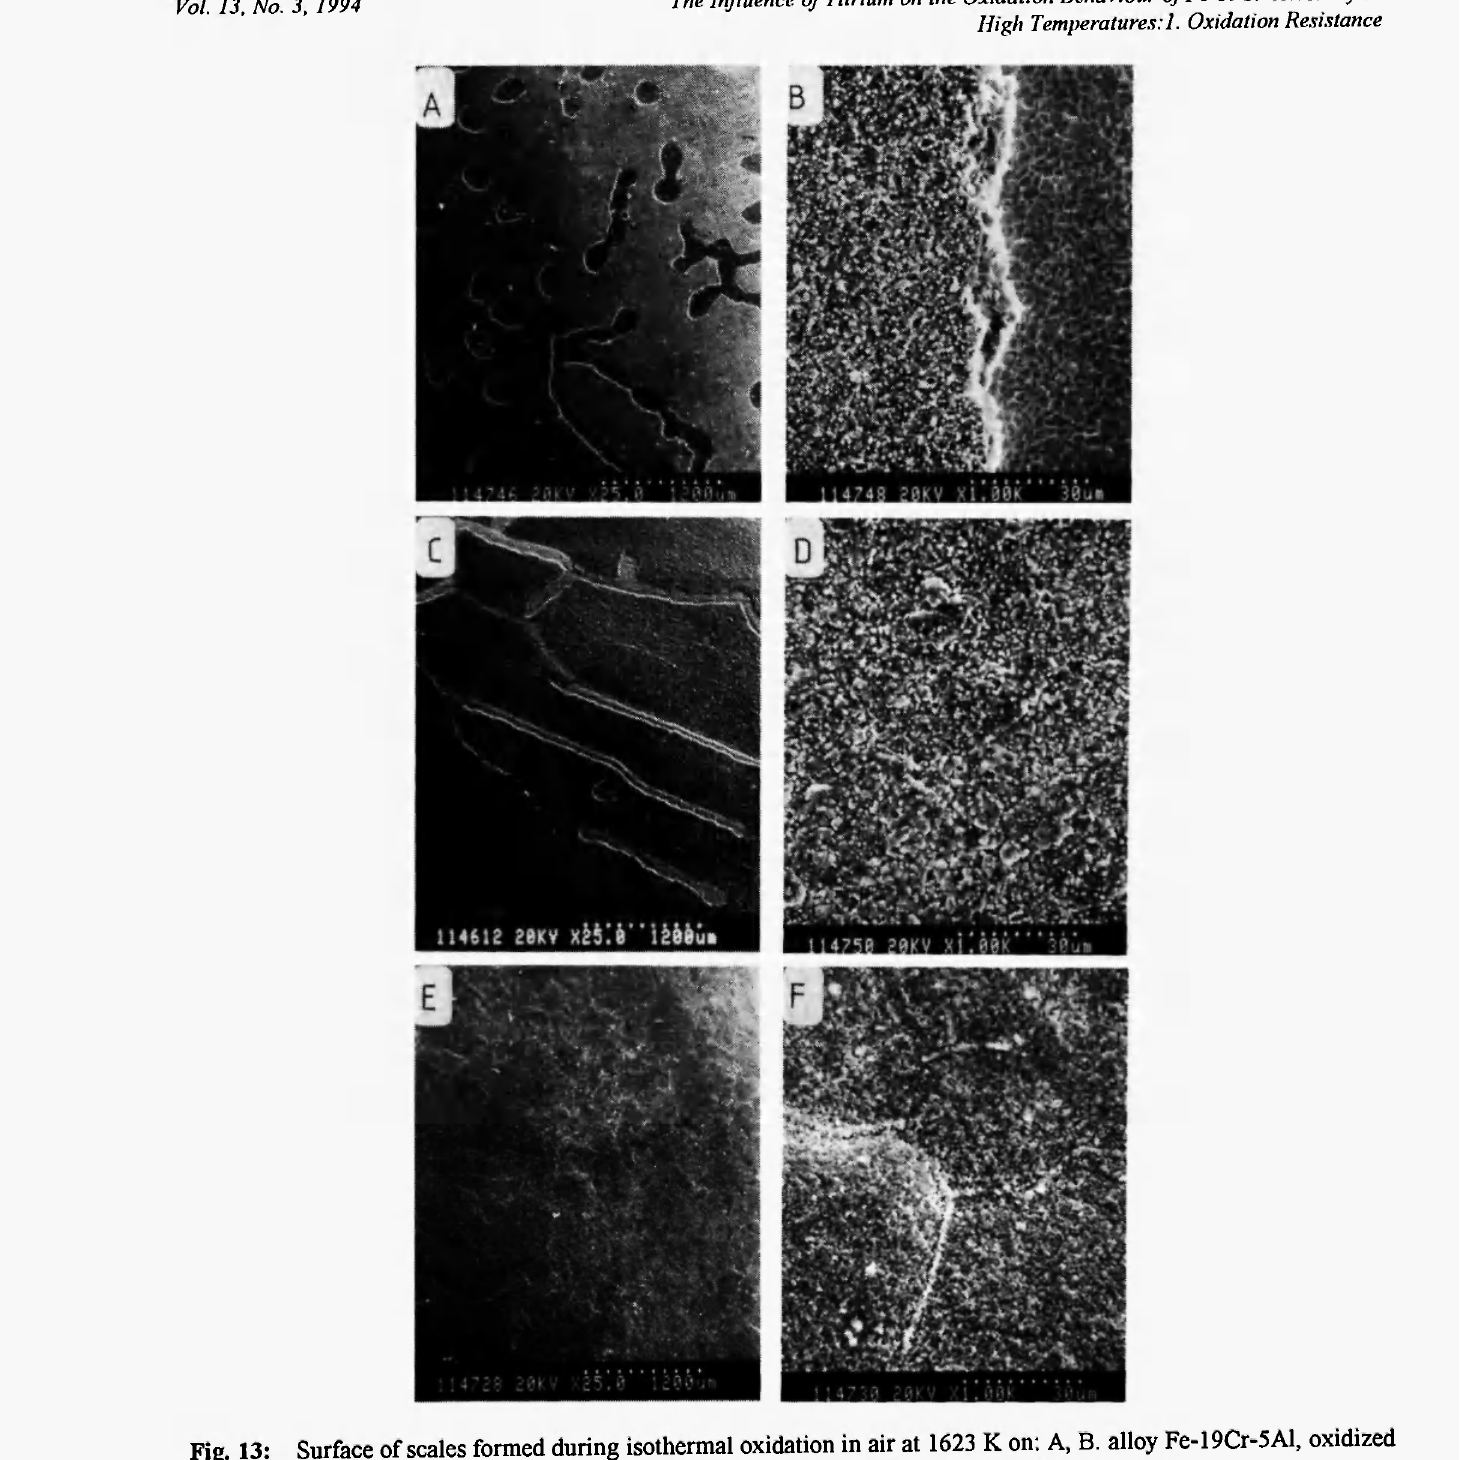
Fig. 13: Surface of scales formed during isothermal oxidation in air at 1623 Κ on: A, B. alloy Fe-19Cr-5Al, oxidized for 52 h, C, D. alloy Fe-19Cr-5Al implanted with yttrium (2xl0 16 Y + /cm 2 ) oxidized for 52 h, E, F. alloy Fe- 19Cr-5Al + 0.27Y oxidized for 42